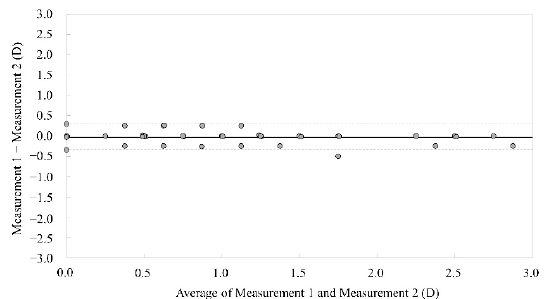
Figure 7. Bland–Altman plots showing the difference between two measurements divided by the mean of these astigmatic measurements in pre-trabeculectomy eyes. The solid lines represent mean differences between two consecutive measurements of corneal astigmatism, dotted lines are the upper and lower borders of the 95% LoA (mean difference ± 1.96 multiplied by standard deviation of the mean